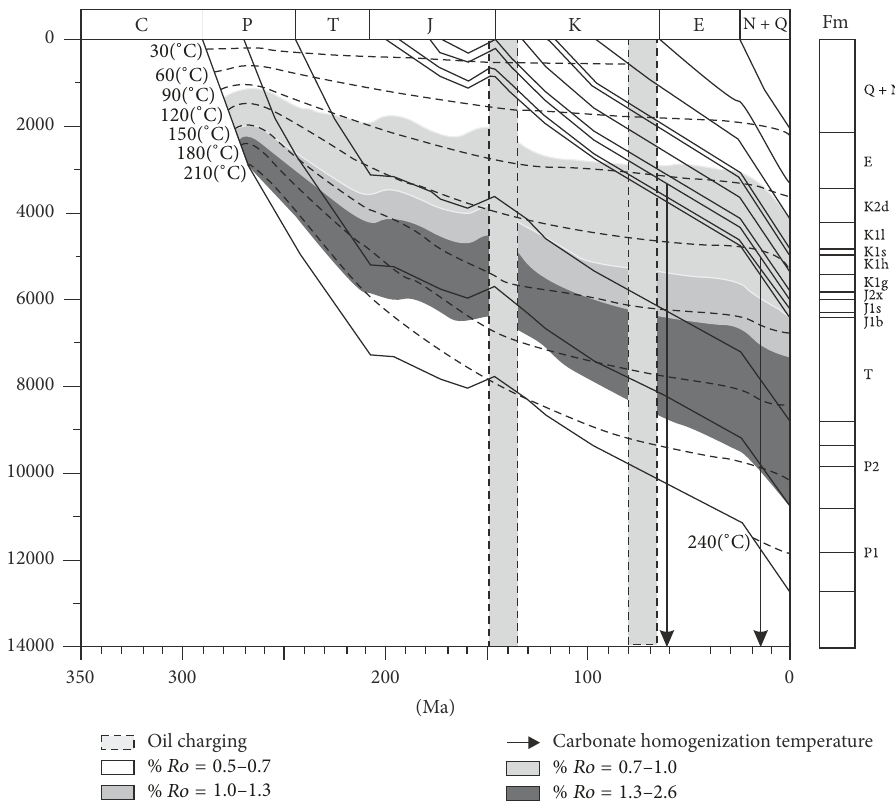
Figure 3: Generalized burial and thermal histories of Y1 well from Block 3 in the central Junggar Basin. Location of the example well is marked in Figure 1.